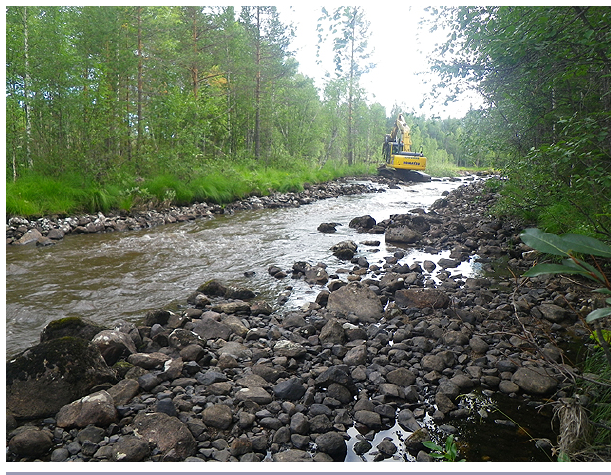
Fig. 2 . Channelized (unrestored) reach of the Vormbäcken stream; the excavator is about to start restoration